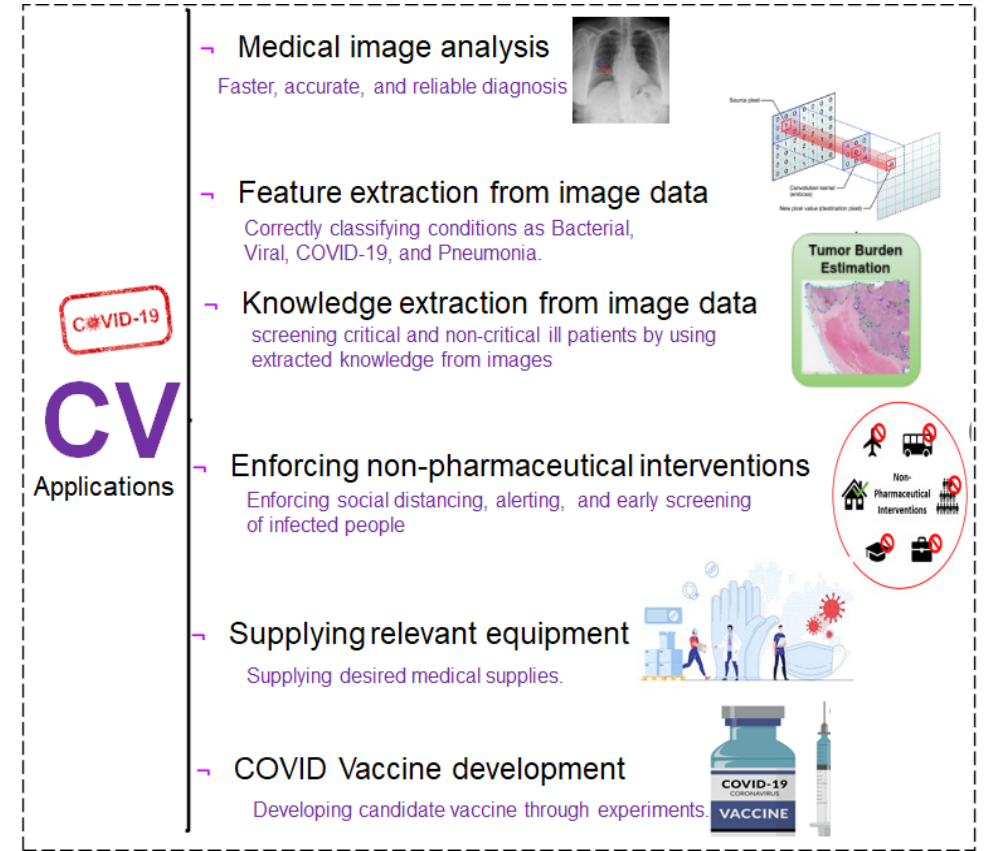
Figure 8. CV applications on image data in the context of COVID-19 (Partially adapted from